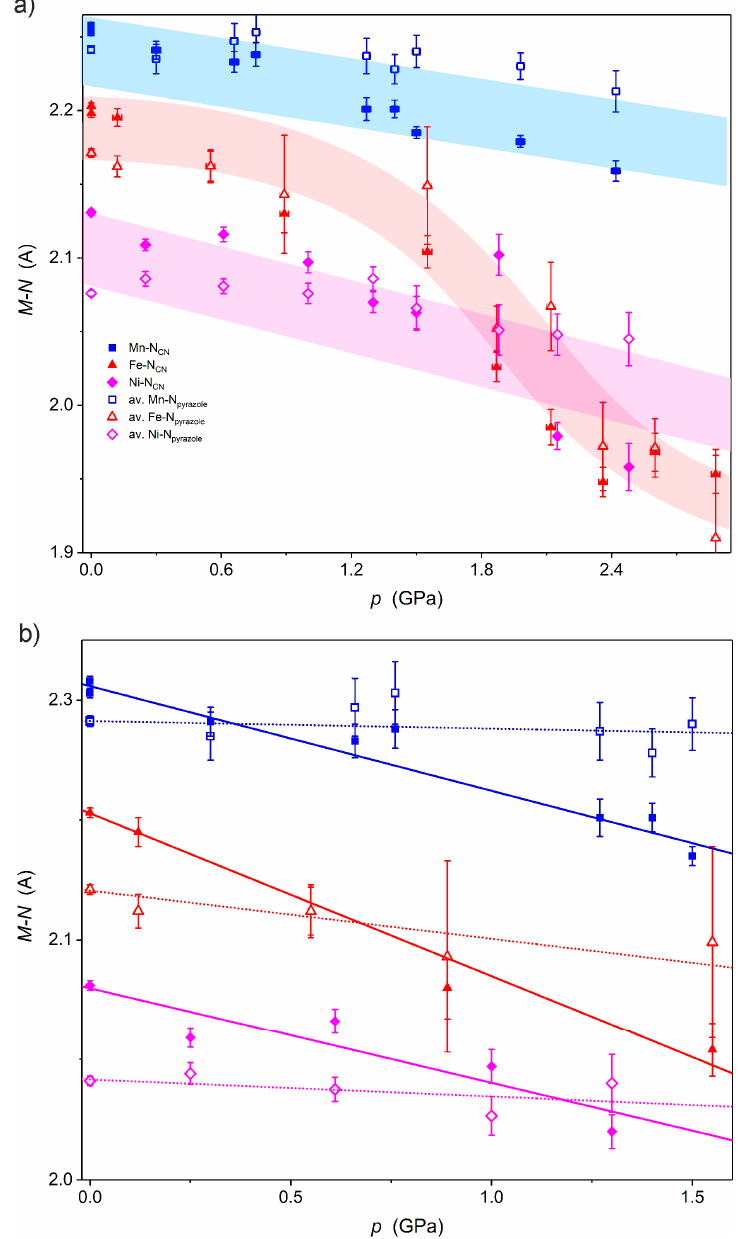
Figure 3. Pressure dependence of the M–N CN bond lengths (full symbols) and M–N pyrazole (open symbols) in the full pressure range ( a ) and in the pressure range where only linear changes are observed ( b ) for Ni 2 Nb (magenta), Mn 2 Nb (blue) and Fe 2 Nb (red). Highlights in (a) are only for guiding the eye, while the lines in (b) are the best linear fit: solid for M–N CN and dotted for M–N pyrazole